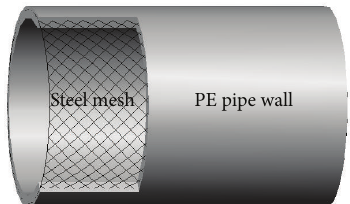
Figure 1: Composition of a PE pipe with steel-mesh reinforcement.